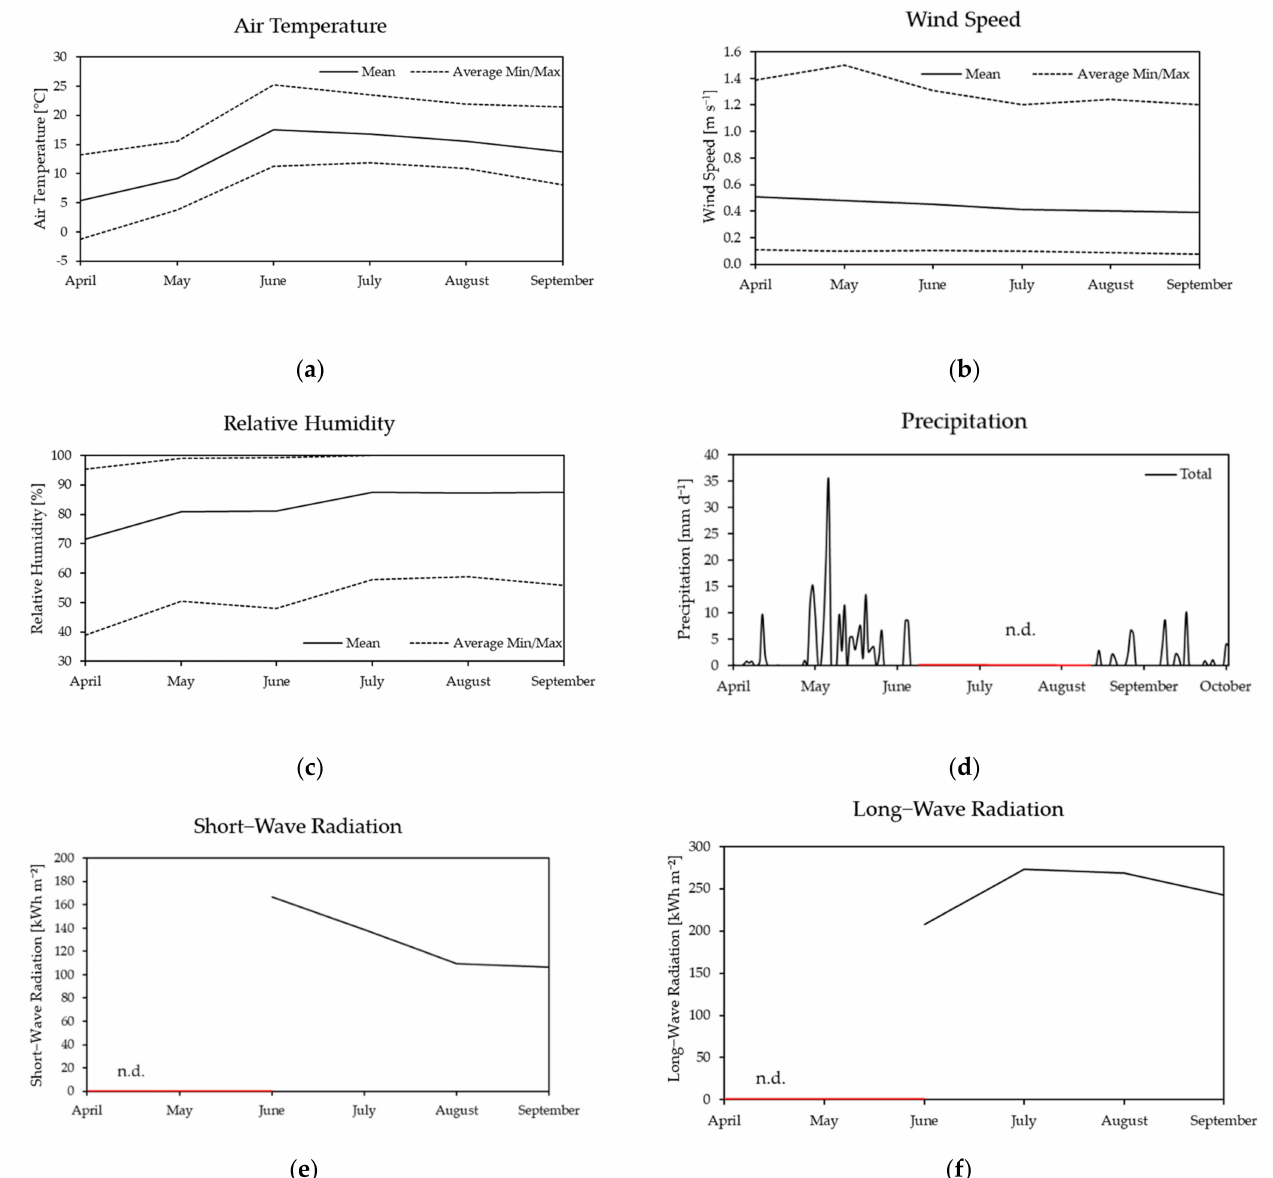
Figure A1. Weather during the study period from April to September 2021, shown as means, with average minimum and average maximum for: ( a ) air temperature; ( b ) wind speed; ( c ) relative humidity; weather during this period shown as average daily sums for: ( d ) precipitation; weather during this period shown as a monthly sum: ( e ) short-wave radiation; ( f ) long-wave radiation. October is not included here as data were only available for four days in that